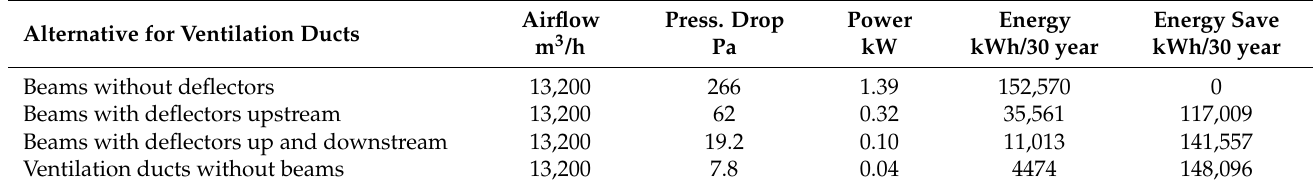
Table 6. Calculation of the power and energy needed to pass the air through the supply and exhaust ventilation ducts with a beam of 288